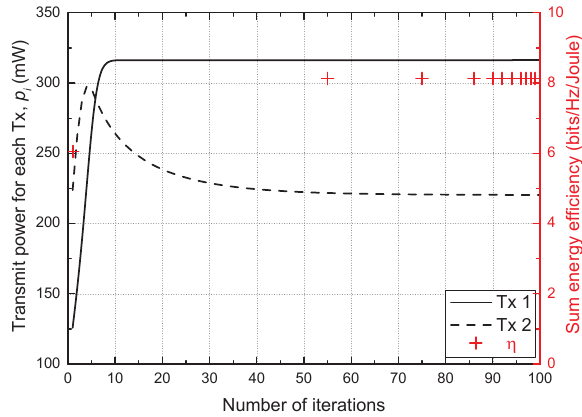
Figure 2. Convergence of the proposed